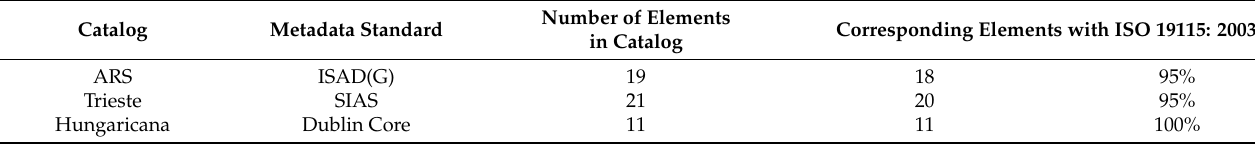
Table 5. Percentage of corresponding elements between used metadata standards in the catalogs with ISO 19115-1: 2014.